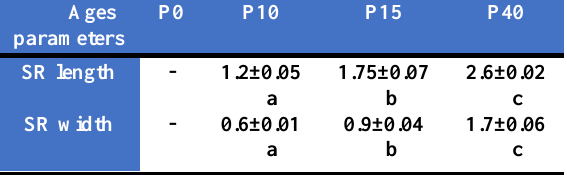
Table, 1: Gross measurements of SR (cm) in rabbits at different post natal ages. ±SE.